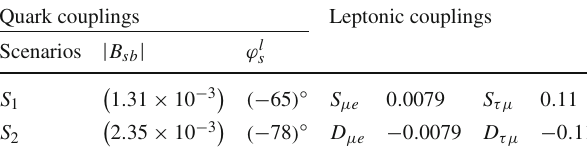
Table 2 Maximum values of NP couplings Quark couplings Leptonic